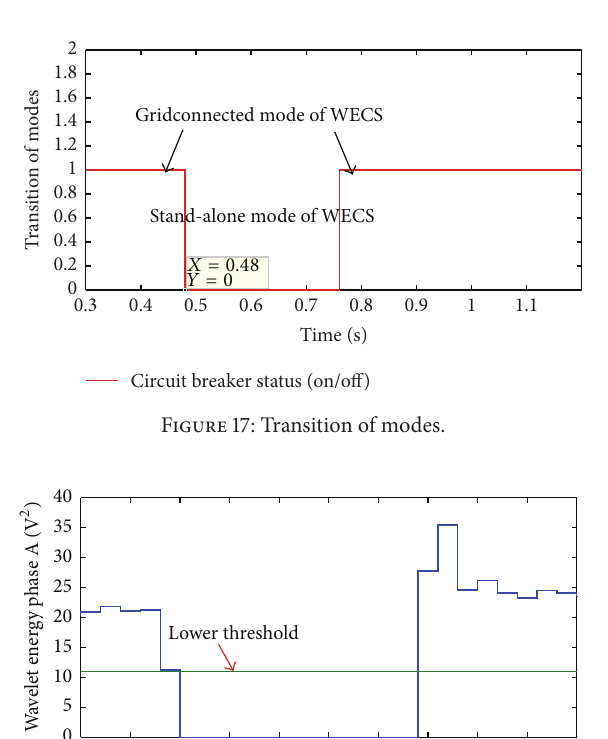
Figure 16: Three-phase voltages at PCC.